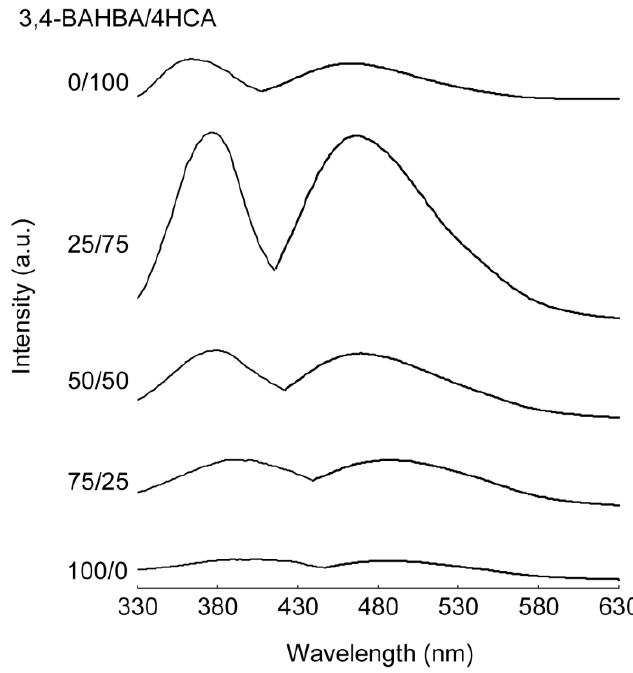
Figure 6. Photoluminescence excitation spectra (left), and emission spectra (right) of Poly(3,4-BAHBA- co -4HCA)s of various molar ratios.